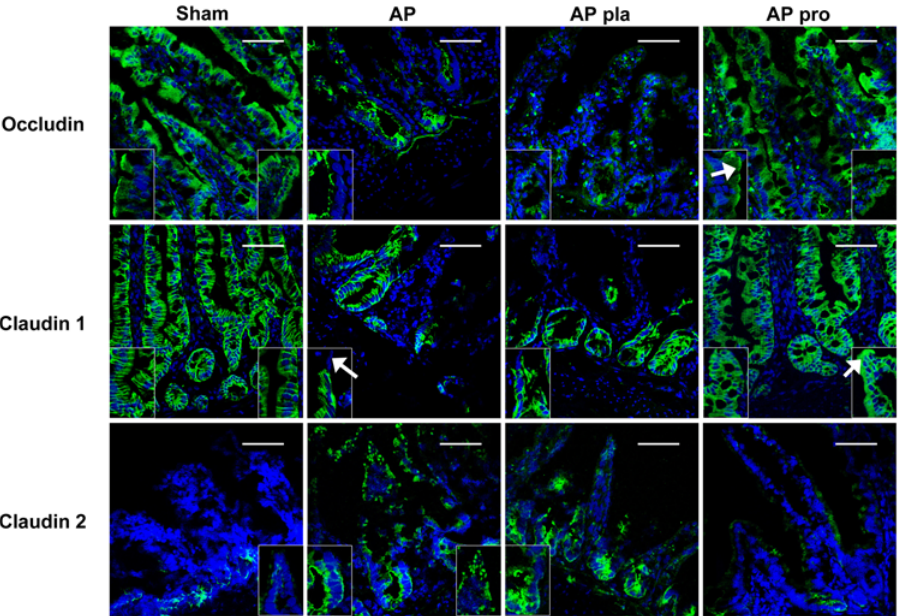
Figure 3. Probiotics prevented disruption of tight junction proteins. After 5 days of pre-treatment with placebo (pla) or probiotics (pro), rats were subjected to acute pancreatitis (AP), or a sham-procedure. Ileal sections were stained with occludin, claudin-1 or -2 antibodies (green), counterstained with DAPI (blue) and visualized by confocal laser scanning microscopy. Bar=500 m m. The higher magnification (100 6 /1.30) images shown in the insets are typical details of crypts (left) and villi (right). Probiotics prevented the deleterious effects of AP on occludin and caused redistribution of occludin to the apical surface (arrowhead). Acute pancreatitis-induced detachment of epithelial cells seems to be preceded by loss of claudin-1 (arrowhead) and was reduced by probiotic pre-treatment; though probiotics could not prevent the AP-induced formation of aggregates of claudin-1 in the cytosol (arrowhead). Probiotics prevented AP-associated up-regulation of claudin-2 in both crypts and villi (arrowhead). The patterns of staining are typical of that seen in 4 sections of 4 rats per